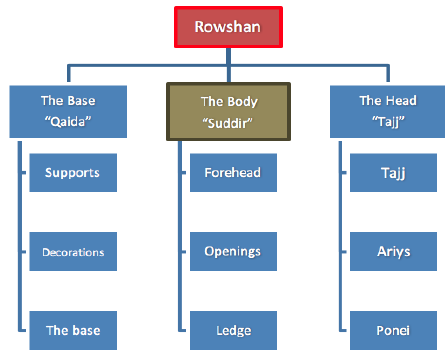
Figure 8. The Roshan parts’ layout.